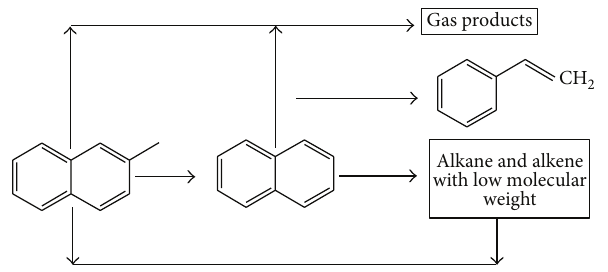
Figure 9: The schematic diagram of generating or cracking of naph- thalene.